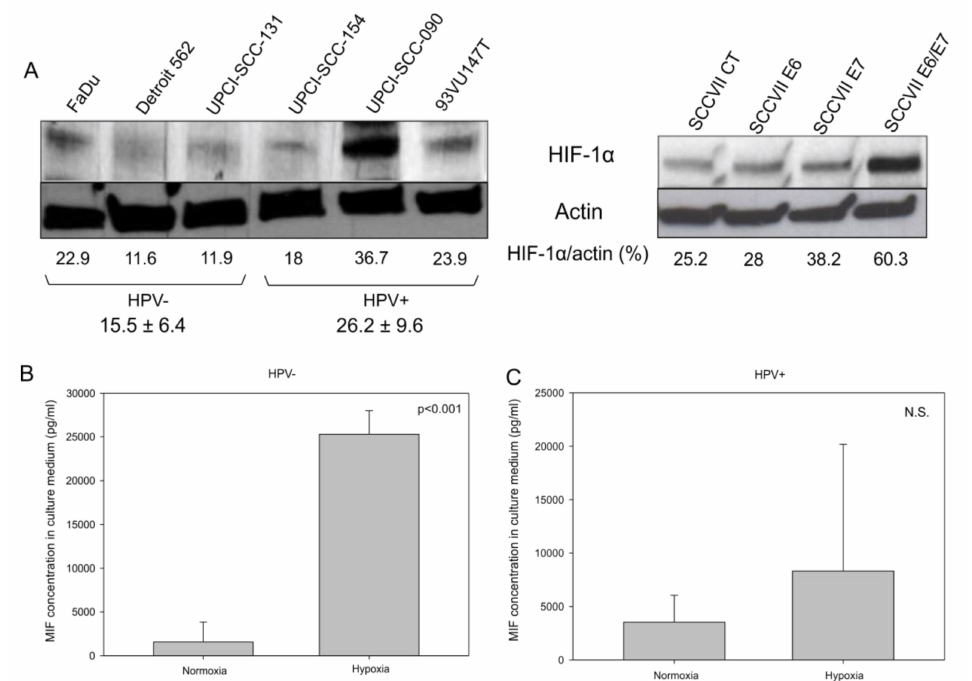
Figure 5. Hypoxia inducible factor 1 α (HIF-1 α ) expression in human and murine cell lines. ( A ) Western blot analysis demonstrating the upregulation of HIF-1 α in two human papilloma virus (HPV)-positive cell lines (UPCI-SCC-090 and 93VU147T) and in the murine SCCVII E6/E7 cell line. Concentration of macrophage migration inhibitory factor (MIF) in the culture medium of ( B ) human HPV-negative cell lines ( p <0.001, Student’s t -test), and ( C ) in human positive cell lines (N.S., Student’s t -test)